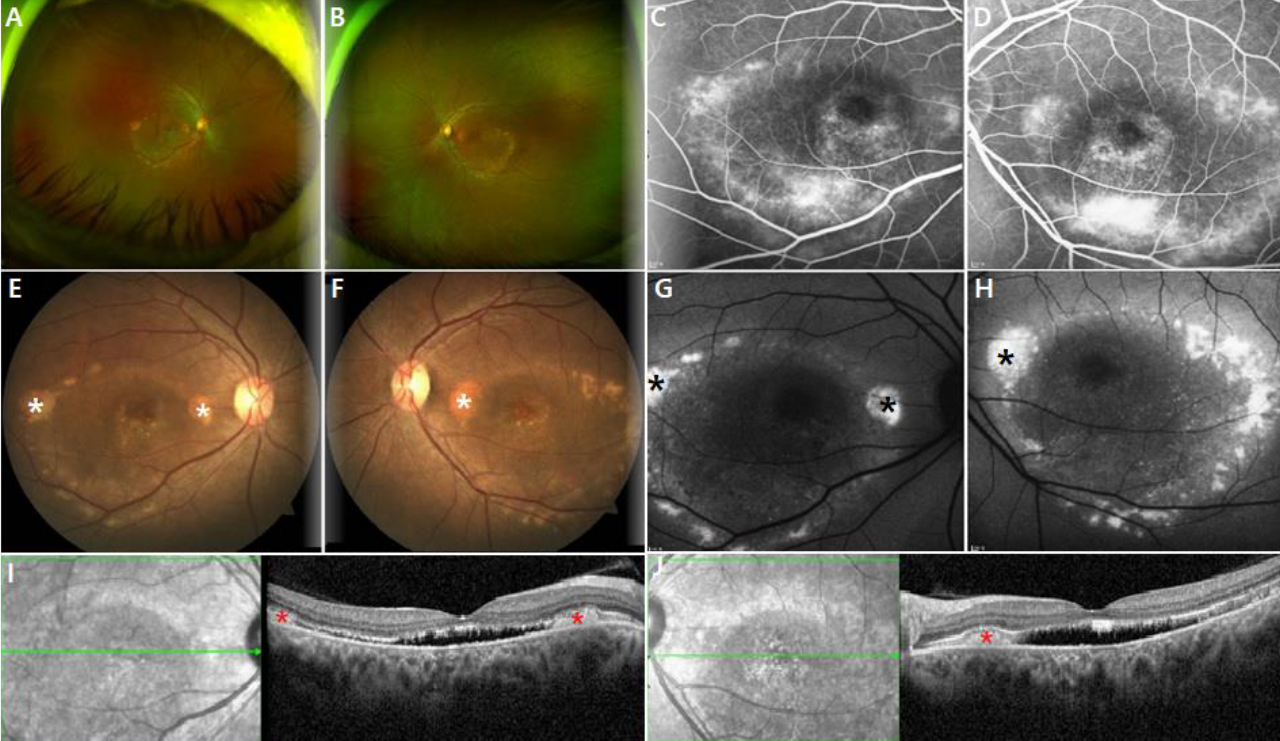
Figure 1. Multimodal retinal imaging of patient 7, a 37-year-old female with p.Ala195Val and p.Arg255Trp mutation in BEST1 . At the initial visit, best corrected Snellen visual acuity was 0.5 for the right eye and 0.8 for the left eye, while the patient complained of subjective vision decrease only